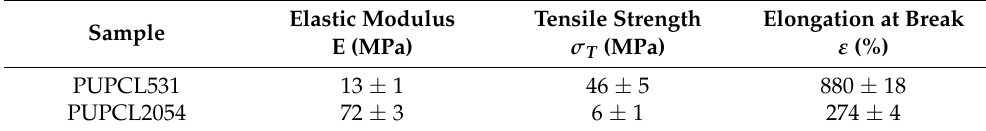
Table 2. Mechanical properties of the samples.